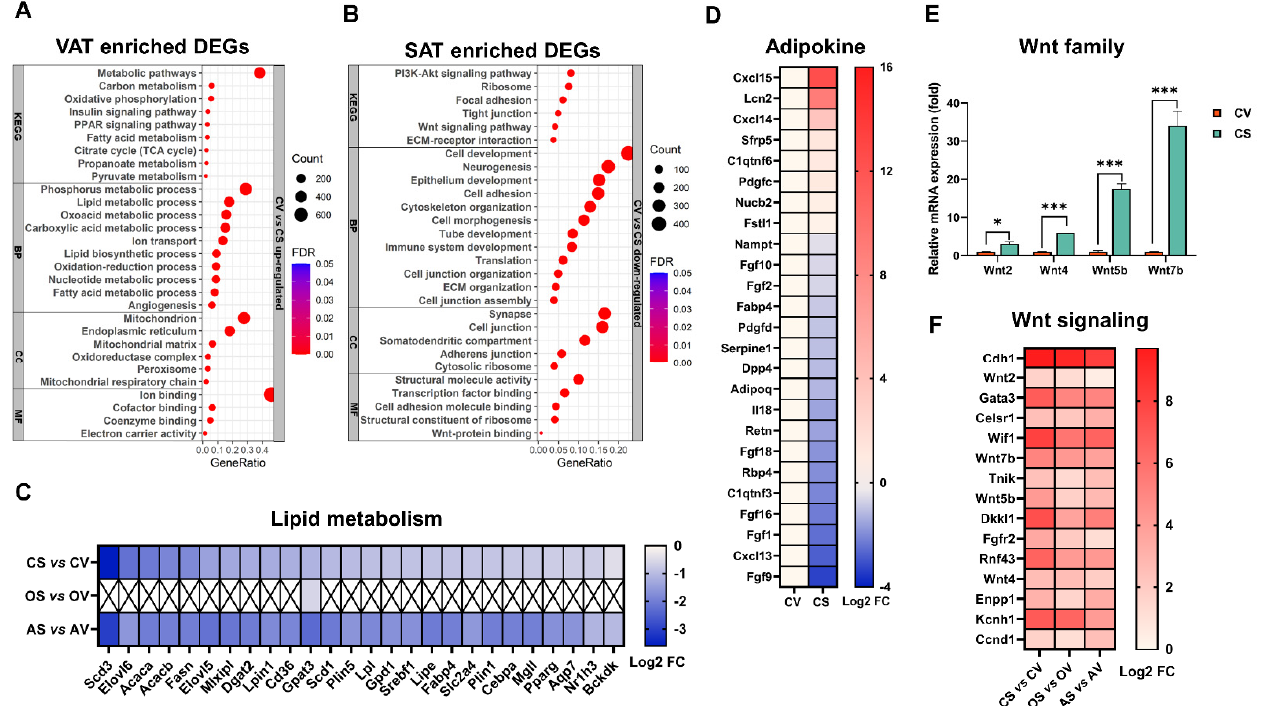
Figure 5. Instinct difference between SAT and VAT in female mice. ( A ) Functional enrichment analysis of the VAT enriched genes (more highly expressed DEGs in VAT than in SAT) in the sham control mice. ( B ) Functional enrichment analysis of the SAT enriched genes (more highly expressed DEGs in SAT than in VAT) in the sham control mice. ( C ) Heatmap of the lipid metabolism associated DEGs between SAT and VAT in the sham control, OVX and ADX mice. ( D ) Heatmap of the adipokine-coding DEGs between SAT and VAT in the sham control mice. ( E ) Expression levels of the Wnt family genes in VAT and SAT of the sham control mice. Data met the criteria for the normal distribution with a similar variance, and a statistical analysis was performed using two-tailed Student’s t -test. ( F ) Heatmap of the Wnt signaling associated DEGs between SAT and VAT in the sham control, OVX and ADX mice. Data are expressed as mean ± SEM. NS , not significant, * p < 0.05, *** p < 0.001. KEGG, Kyoto encyclopedia of genes and genomes; BP, biological process; CC, cellular component; MF, molecular